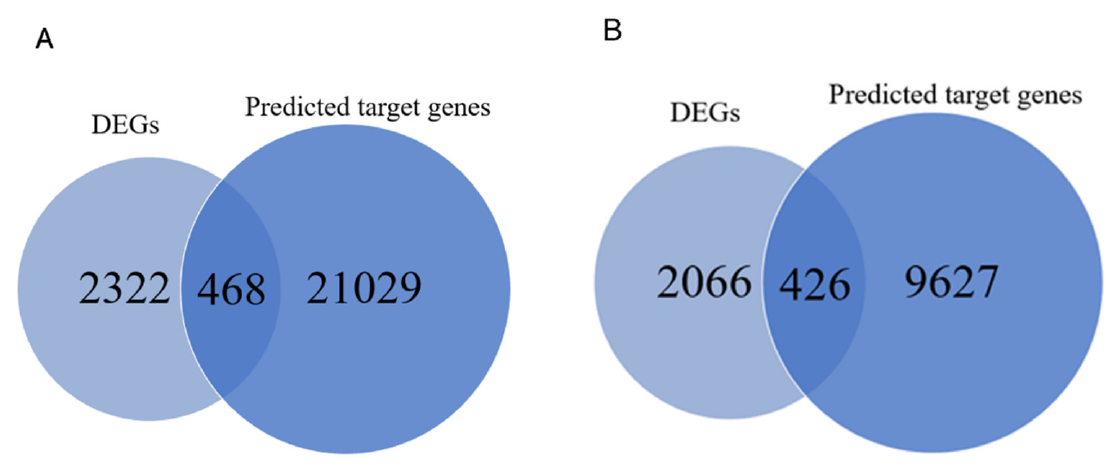
Figure 5. Overview of mRNA ‐ miRNA networks. ( A ) Overlapping genes in SP21 − HYP vs. LP21 − HYP between DEGs and predicted target genes by miRNAs. ( B ) Overlapping genes in SP21 − PD vs. LP21 − PD between DEGs and predicted target genes by miRNAs.